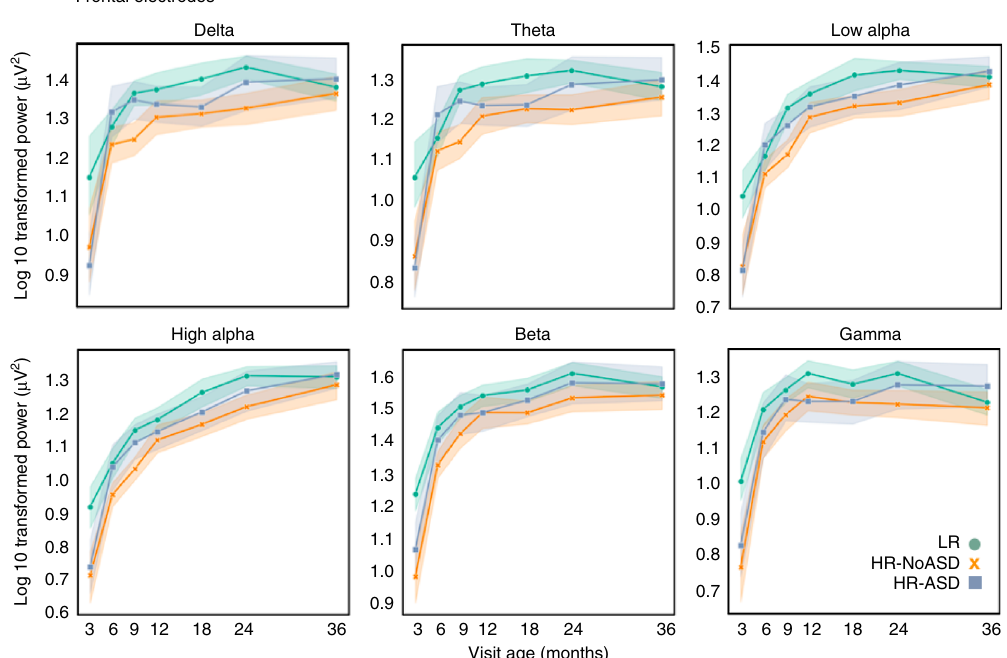
Fig. 3 EEG power from 3 to 36 months of age. Mean log of EEG power, calculated as the sum of the power across each frequency band, is shown for each frequency band over all visit ages for each outcome group, low-risk control (LRC, represented by green circles), high-risk without Autism (HRA − , represented by orange letter x), and high-risk with Autism (ASD, represented by blue squares) for the frontal region of interest. Lines connecting power values across visit ages are to aid visualization. Error bars are 95% con fi dence intervals around the